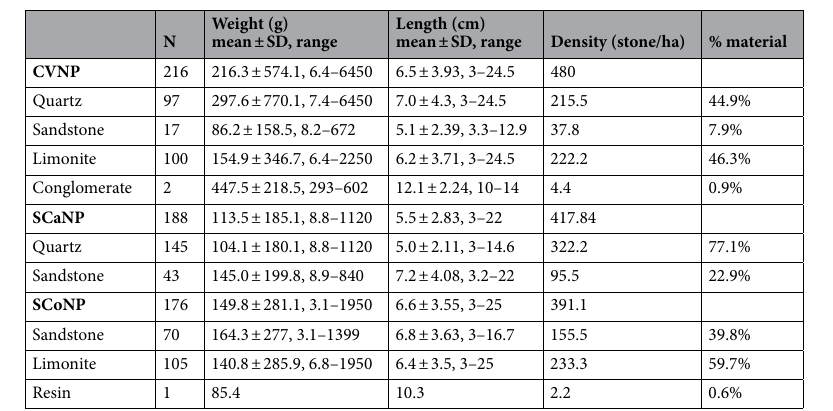
Table 3. Lithic raw material characteristics in each site, from plot samples. Only stones with more than 3 cm were considered in this sampling.